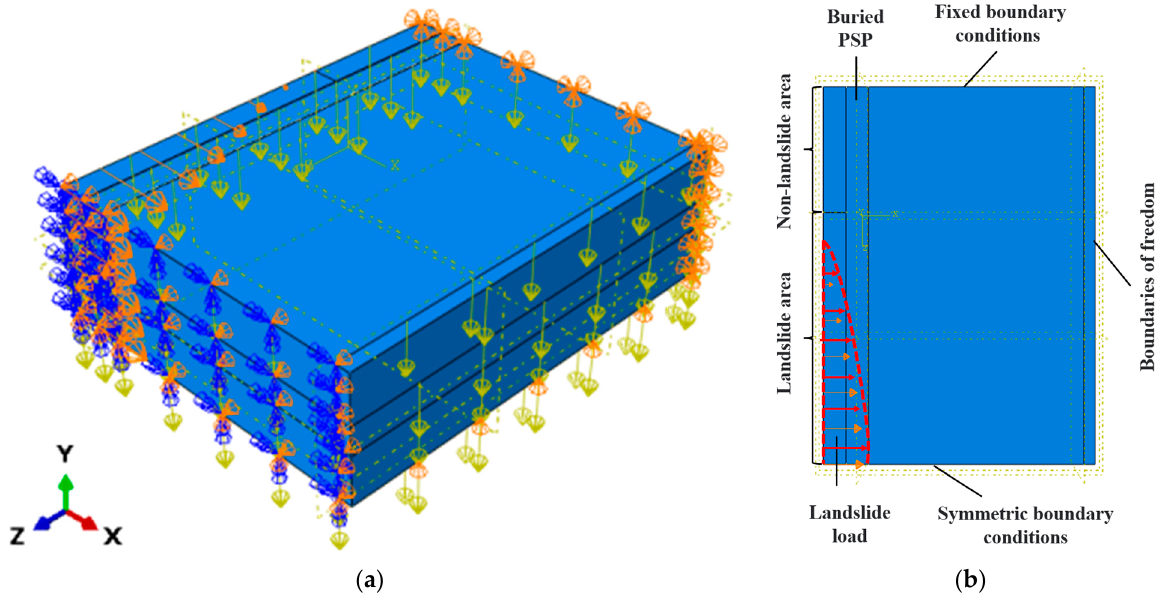
Figure 7. Boundary conditions of the finite element model: ( a ) Isometric view; ( b ) Top view.